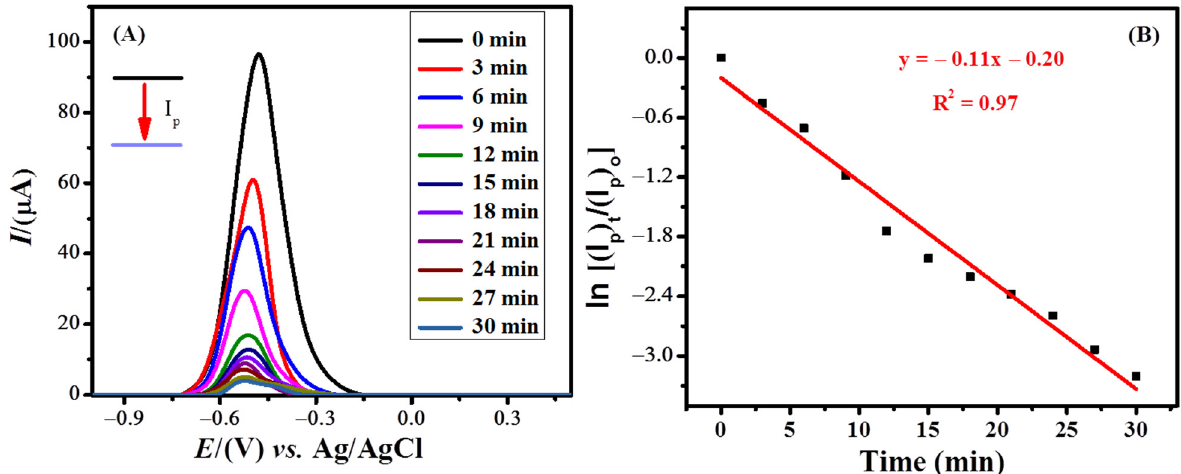
Figure 8. ( A ) SW voltammograms of the photocatalytic degradation of MB on NH 2 - f MWCNTs/GCE using TiO 2 nanoparticles under deposition potential of − 0.3 V and deposition time of 60 s. ( B ) A linear plot showed first-order kinetics of the photocatalytic degradation of methylene blue.